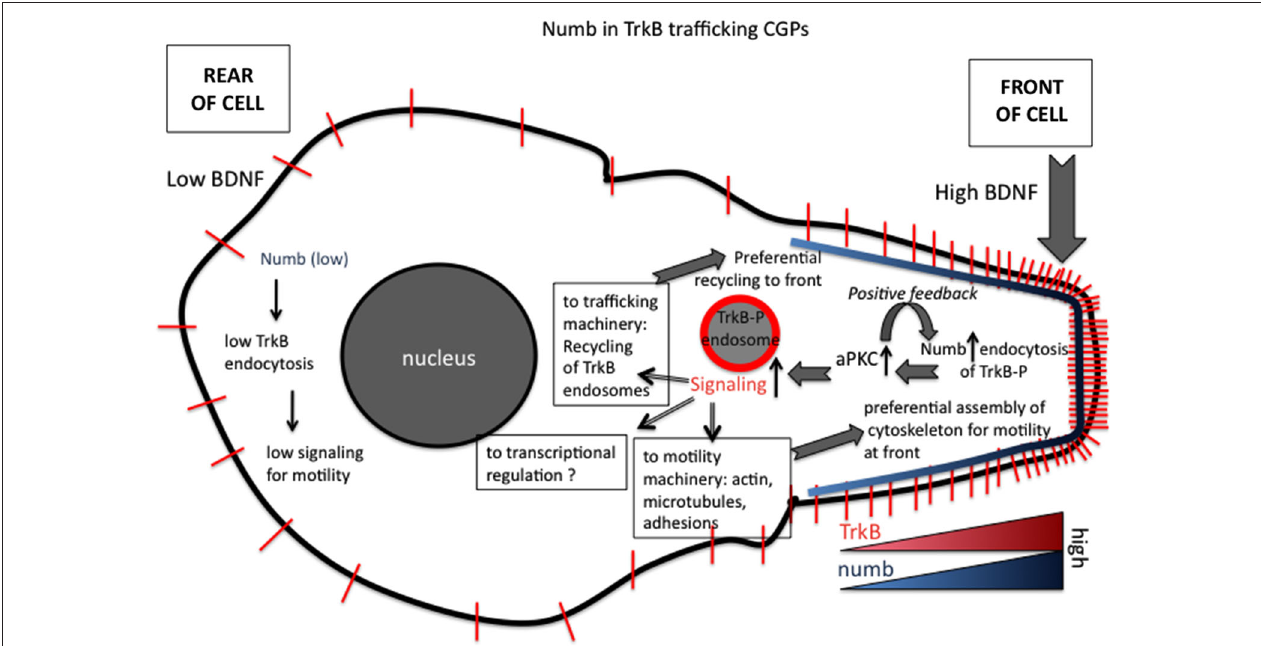
effectors, such as aPKC. (5) Higher numb leads to higher TrkB-P endocytosis via clathrin/AP-2. (6) Higher TrkB endocytosis leads to more TrkB-P in endosomes. (7) More TrkB-P in endosomes recruits more signaling effectors to endosomes. (8) Higher activation of Tiam and Rac to promote more actin assembly in front of cell. (9) Higher signaling promotes preferential recycling of TrkB back to surface at front. (10) TrkB distribution becomes more polarized near